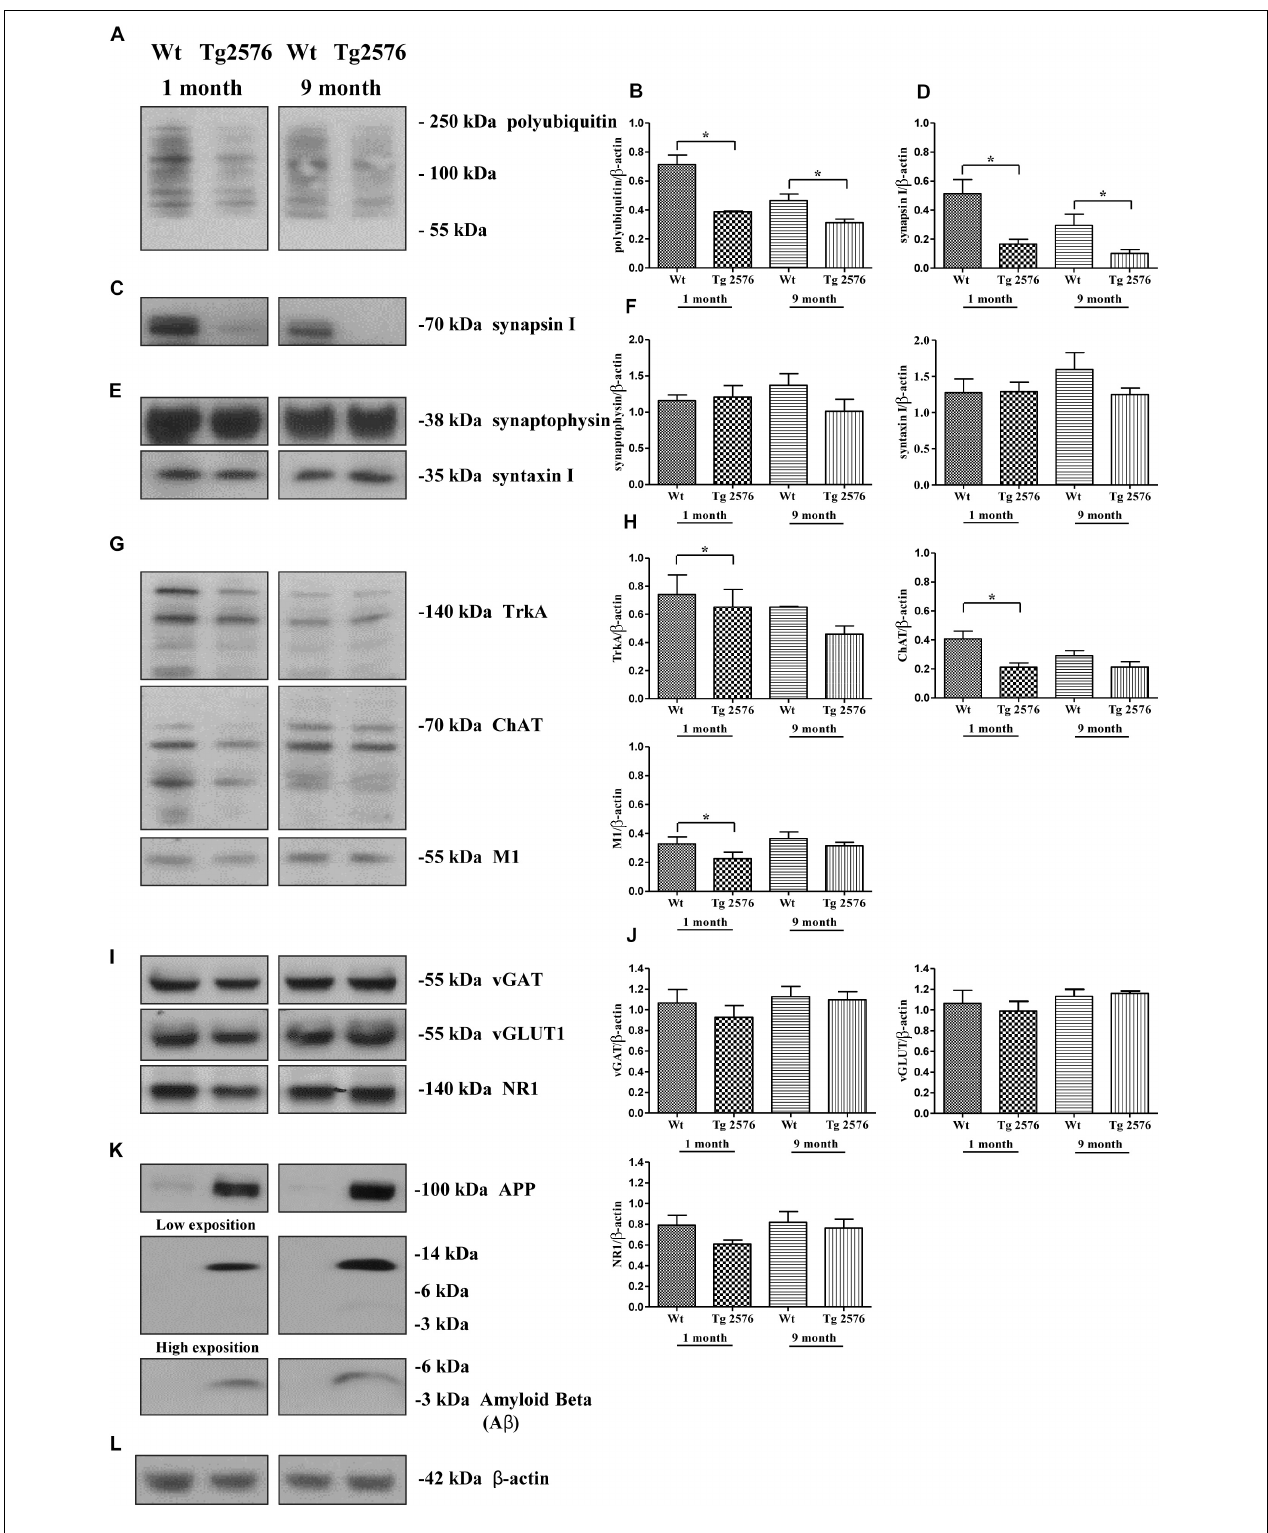
FIGURE 8 | Early and selective degeneration of cholinergic afferent inputs is paralleled by the decline of presynaptic markers and loss in polyubiquitin-conjugates in hippocampi from transgenic Tg2576 AD mice, just mirroring the in vitro “dying-back”-like mechanism(s) of NGF-deprived cholinergic neurons. (A–L) Crude synaptosomal preparations of hippocampi representing mainly the presynaptic compartment (Gylys et al., 2004) were isolated from 1-month-old and 9-months-old Tg2576 AD mice and age-matched littermate Wt ( n = 4–6 pooled mice lysates/experimental group) and analyzed by Western blotting for the expression levels